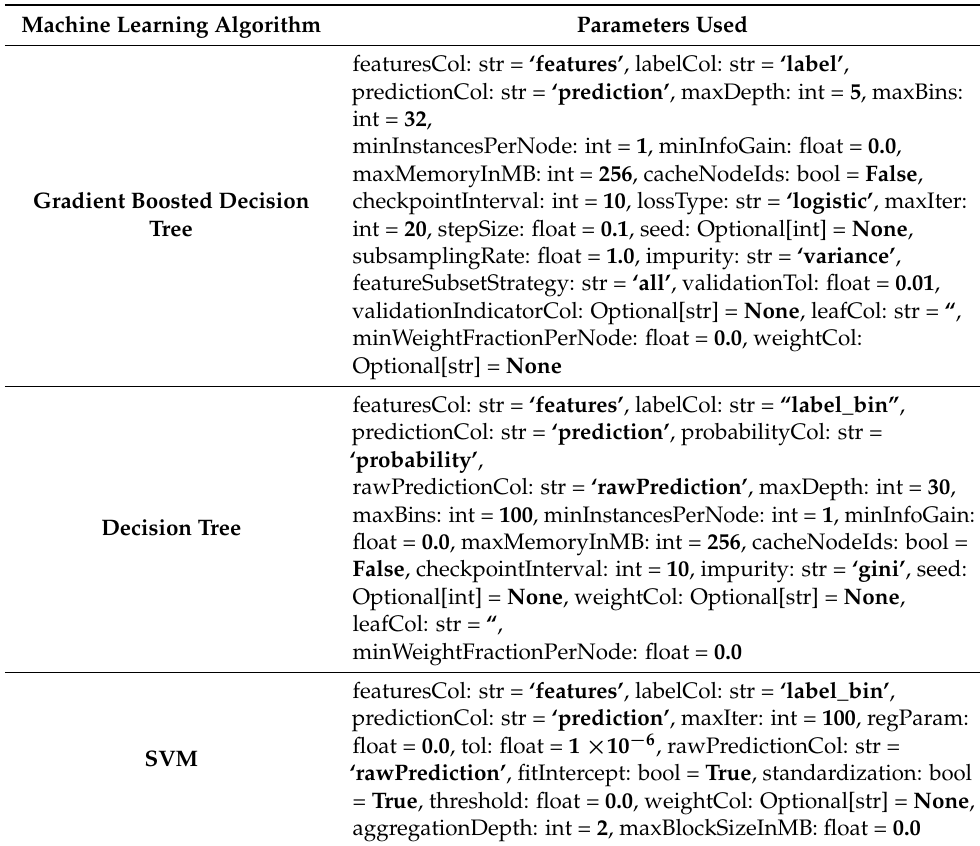
Table 13. Cont. Machine Learning Algorithm Parameters